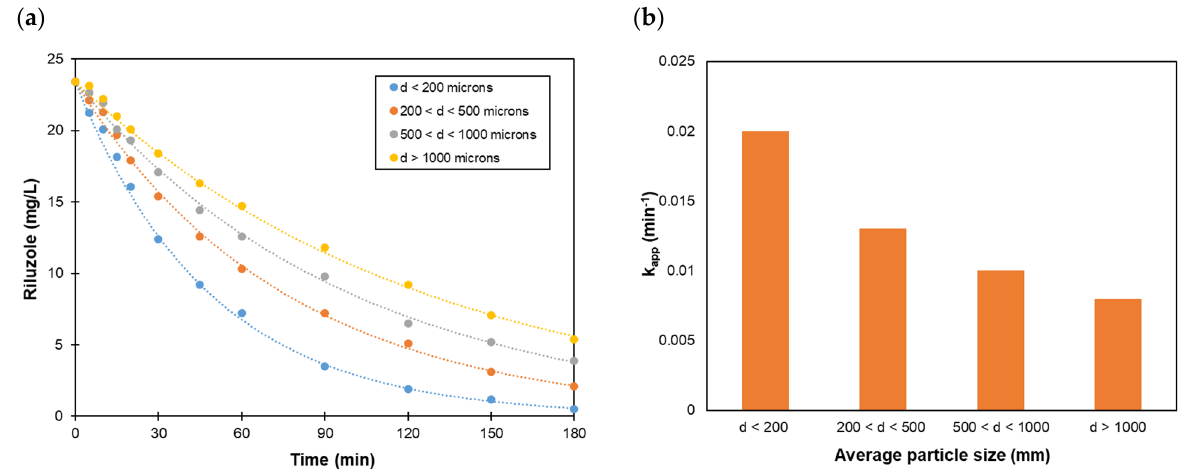
Figure 4. Effect of Fe-based catalyst particle size on ( a ) the changes of riluzole concentration with time and ( b ) the pseudo-first order rate constant during the treatment of 23.4 mg/L riluzole aqueous solutions using Fe-based catalyst/H 2 O 2 system (exponential trend lines are added to graphs in dashed lines). Experimental conditions: H 2 O 2 : 1000 mg/L, Fe-based catalyst: 200 mg/L, pH = 3.0, Temperature: 23–25 ◦ C, Mixing rate: 400